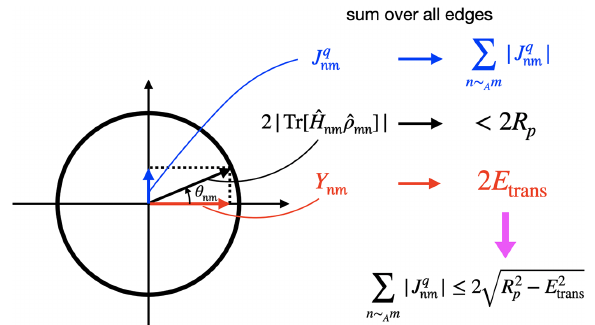
FIG. 4. Schematic illustration of the trade-off relation between the current and the expectation value of the transition energy. The local current | J q nm | and the expectation value of the local tran- sition Hamiltonian ∝ Y nm cannot be simultaneously large when 2 | Tr[ ˆ H nm ˆ ρ mn ] | is fixed, since | J q nm | = 2 | Tr[ ˆ H nm ˆ ρ mn ] | sin θ nm and Y nm = 2 | Tr[ ˆ H nm ˆ ρ mn ] | cos θ nm , where θ nm plays the role of the dif- ference in quantum phases. Summation over all of the edges n ∼ A m leads to the trade-off relation between R p , as detailed in Appendix